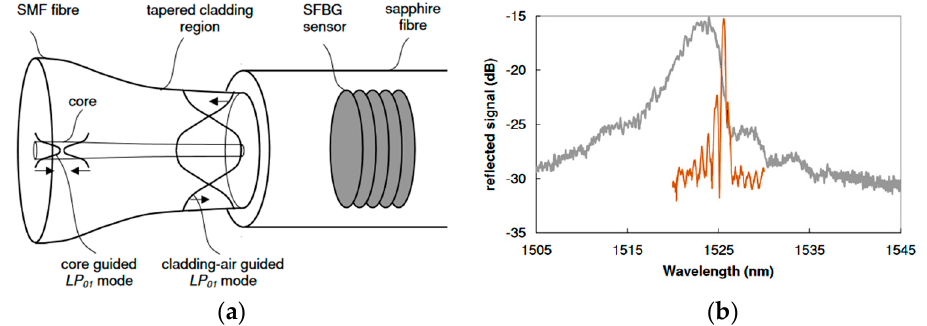
Figure 14. ( a ) Schematic of the tapered fiber coupling method to reduce the spectral width of SFBG; ( b ) Comparison of single-mode (orange line) and multimode (grey line) reflection spectra of the SFBG. (Reprinted with permission from Ref.